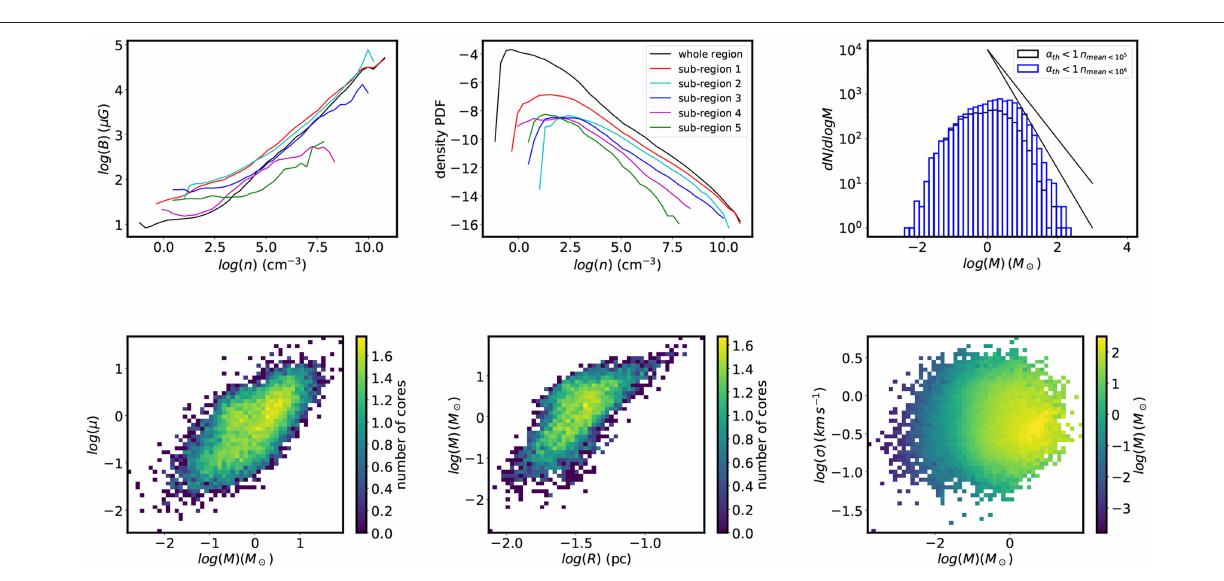
(Ward-Thompson et al., 2007; Offner et al., 2014), seemingly suggesting that the CMF may be at the origin of the